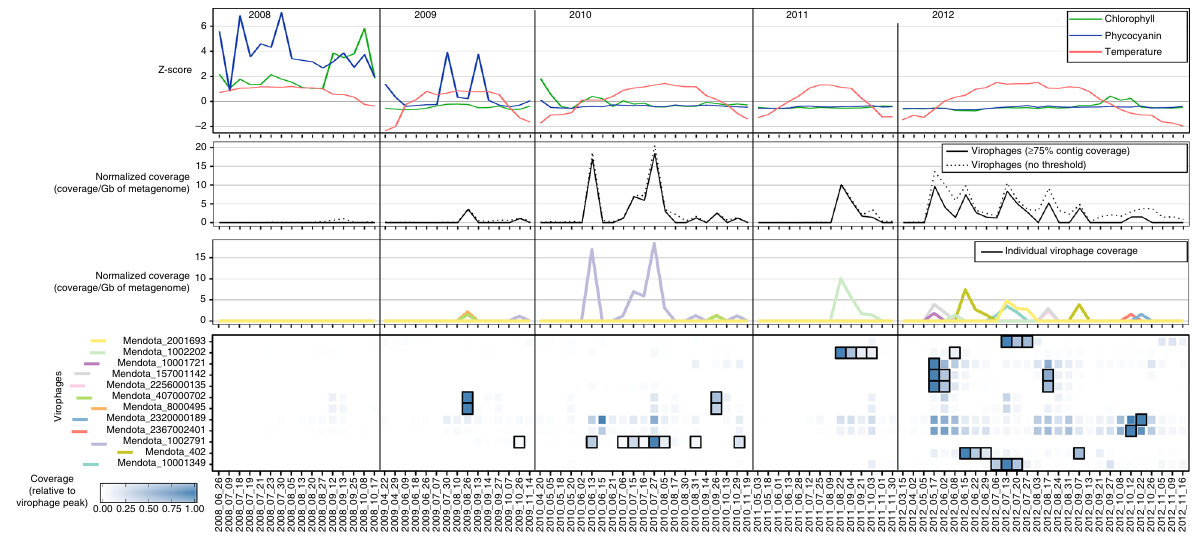
Fig. 4 Virophage abundance and the environmental data in Lake Mendota. Pigment concentrations and temperature are presented as Z-scores to focus on their variations across the time series rather than their absolute values. Virophage abundance are based on the mapping of metagenomic reads to virophage contigs. Individual virophage coverage is plotted in the third panel and highlighted with a black outline in the heatmap (fourth panel) when > 75% of the contig is